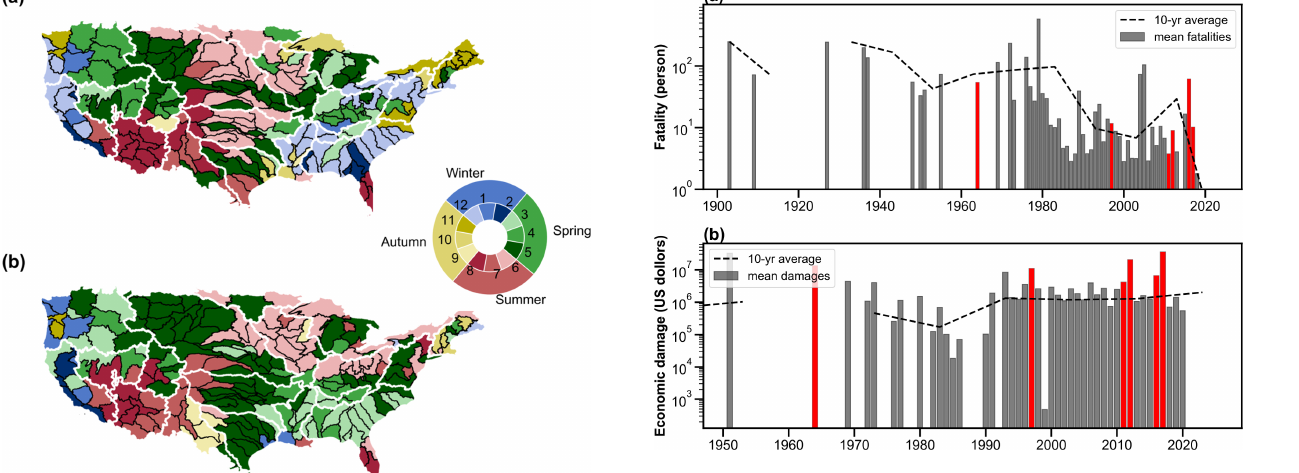
Figure 5. Time series of flood impacts: (a) mean fatalities per event and (b) mean economic damages per event (US dollars based on 2020). The highlighted bars represent 1964, 1997, 2011, 2012, 2016, and 2017, which are the active hurricane seasons on